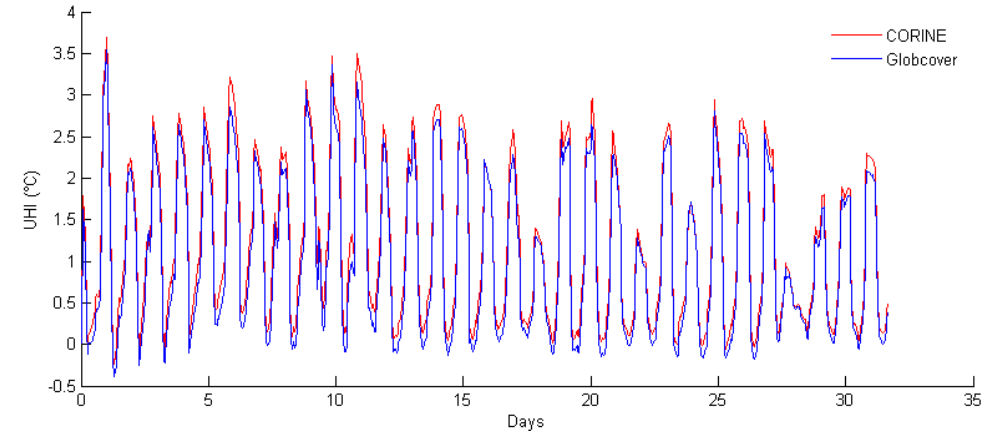
Figure 3. UHI intensity in Antwerp during August 2003 for the CORINE (red) and GlobCover/MODIS (blue) test